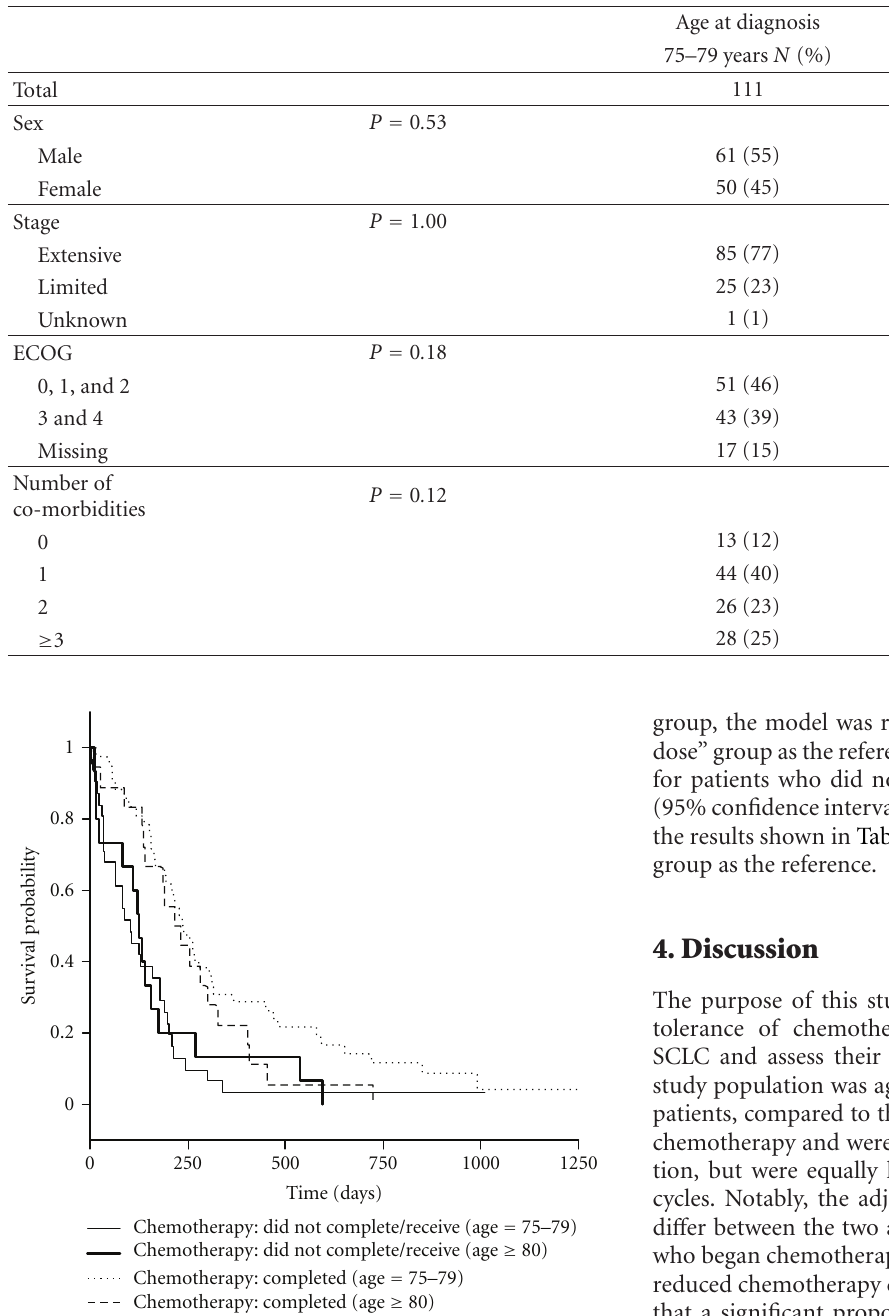
Figure 2: Kaplan-Meier survival curves of all SCLC patients who had an oncologist-consult by chemotherapy completion status, where T0 is 12 weeks after